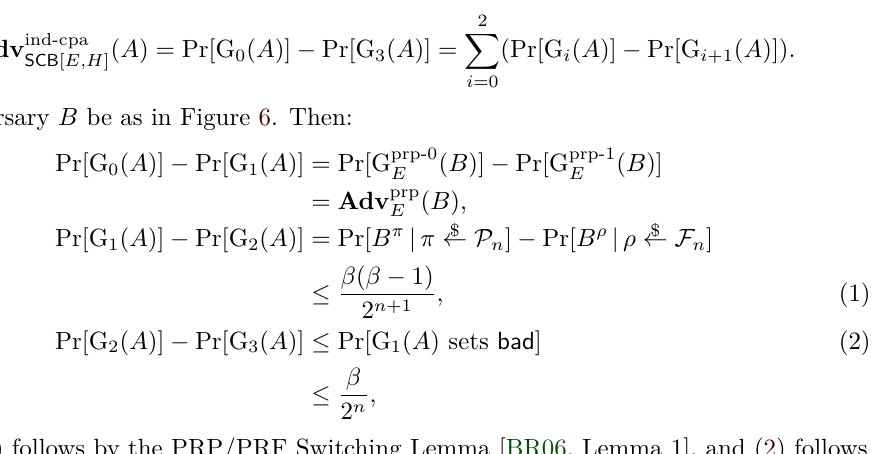
lines 16 and 24, but crucially, any repeated query will be input to ρ once at line 16 and once at line 24. More precisely, since β ≤ 2 σ , it is impossible to query ρ twice the same value at line 16 (this is guaranteed by the check at line 12), and it is also impossible to query ρ twice the same value at line 24 (this is guaranteed by the constantly increasing